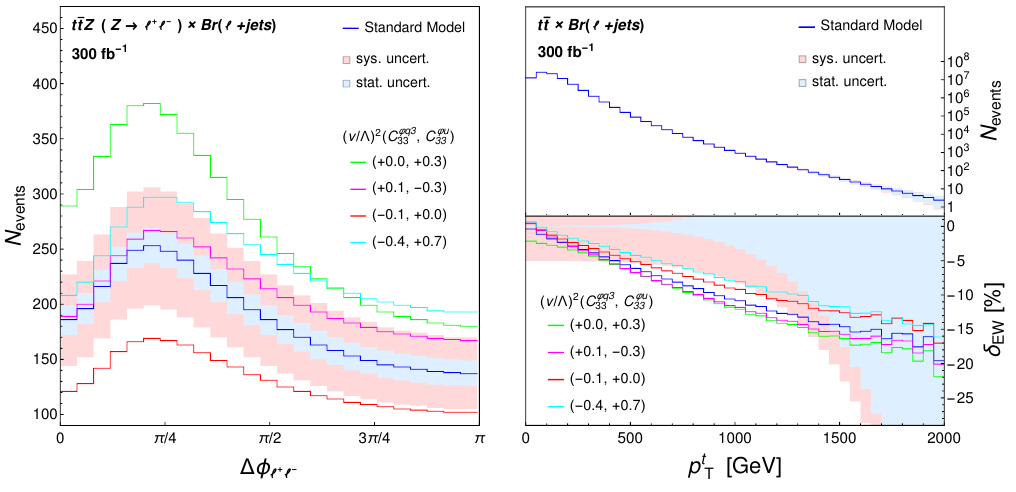
Figure 5 . Left: distribution of (cid:1) (cid:30) ‘‘ in t (cid:22) t + Z production at 13 TeV. Right: p t in t (cid:22) t production at 13 TeV and the relative weak correction below. The SM prediction is shown in blue, together with statistical and systematic uncertainty bands. Modi(cid:12)cations from SMEFT contributions are shown for four selected values of C ’q 3